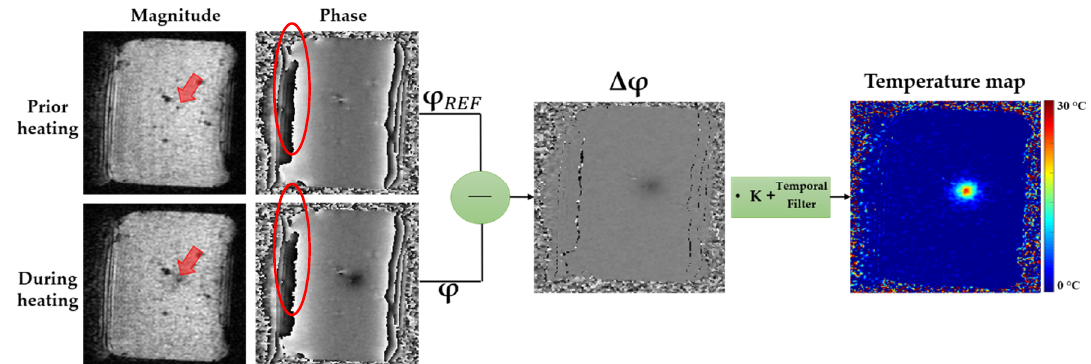
Figure 1. Computational process to reconstruct temperature maps using PRF thermometry method during agar gel laser ablation. Laser applicator is perpendicularly positioned respect to the imaging plane and can be depicted in the magnitude image (red arrow).